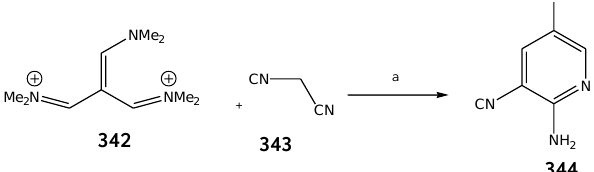
Scheme 27. Synthesis of formyl pyridine. a = AcONH 4